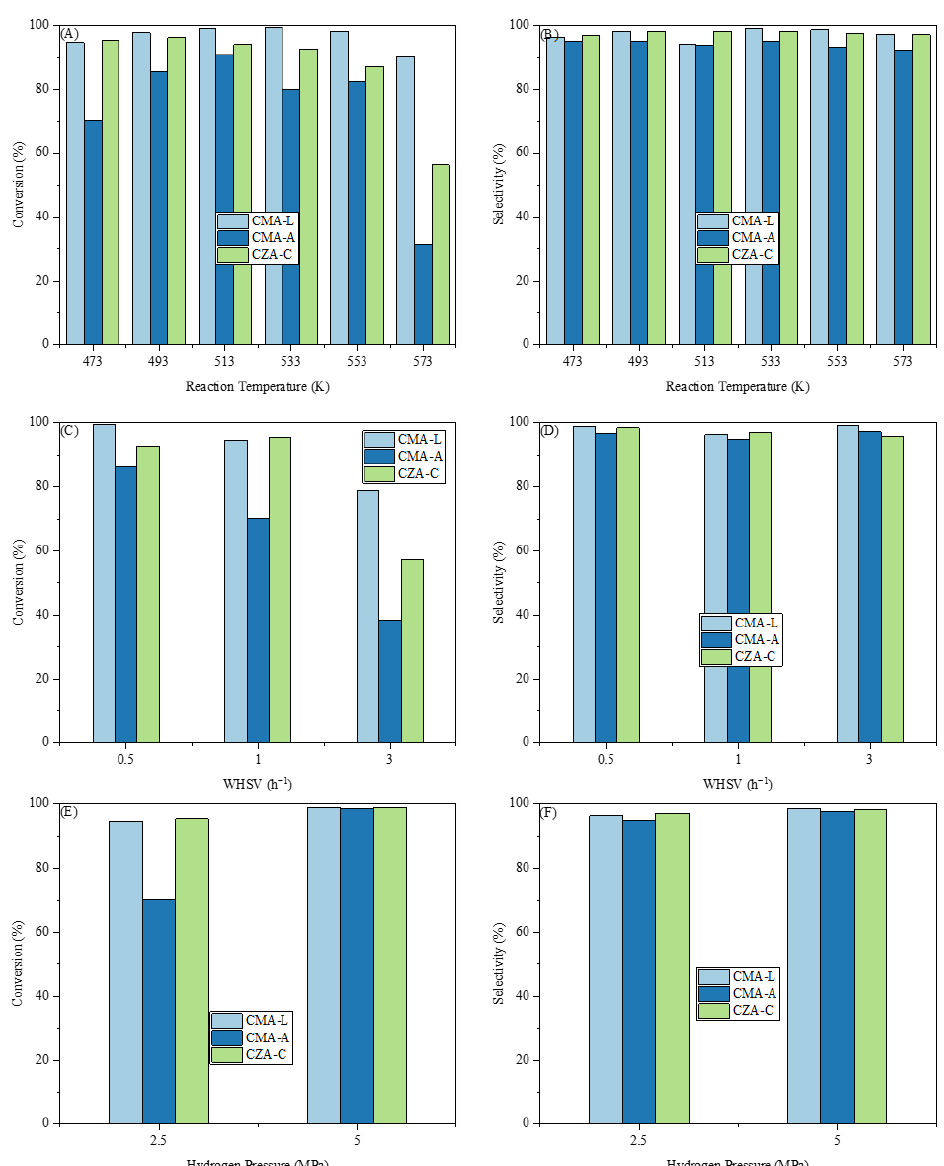
Figure 3. The effects of reaction parameters on the hydrogenation of CHA over Cu-based catalysts: conversion rate ( A ) and selectivity ( B ) at different reaction temperatures, obtained after reduction at 523 K, H 2 pressure: 2.5 MPa, H 2 /CHA molar ratio = 20:1, WHSV = 1.0 h − 1 ; conversion rate ( C ) and selectivity ( D ) at different WHSVs, after reduction at 523 K, and the reaction at 473 K, H 2 pressure: 2.5 MPa, H 2 /CHA molar ratio = 20:1, conversion rate ( E ) and selectivity ( F ) at hydrogen pressures of 2.5 MPa and 5.0 MPa, after reduction at 523 K, and the reaction at 473 K, H 2 /CHA molar ratio = 20:1, WHSV = 1.0 h − 1 .